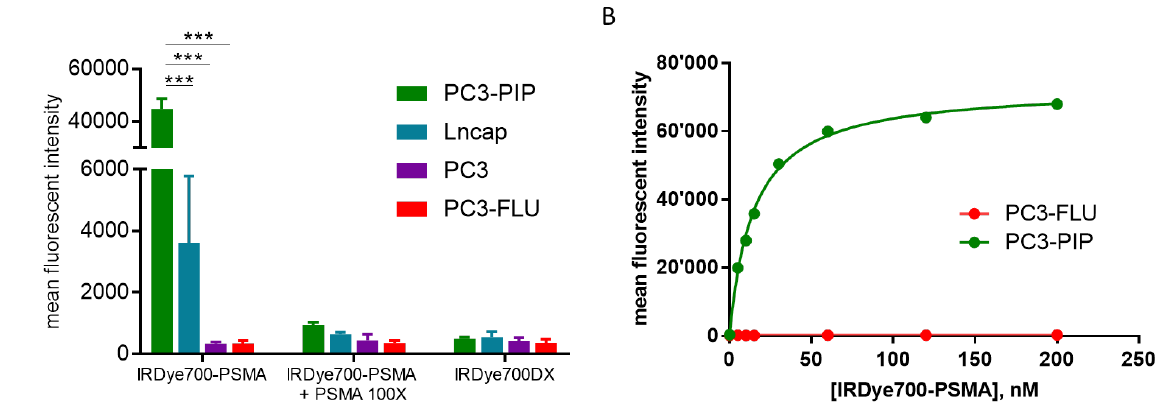
Figure 2. ( A ) Fluorescence emission of PC3-PIP (green), LNCaP (blue), PC3 (violet), PC3-FLU (red) cells following incubation with IRDye700DX-PSMA (500 nM), IRDye700DX (500 nM) and IRDye700DX-PSMA together with non-fluorescent peptide (50 µ M). 2-way anova Bonferroni post hoc, *** p < 0.0001 n = 3; ( B ) Dose-dependent binding of IRDye700DX-PSMA to PC3-PIP (PSMA+ cell) and PC-3- FLU (PSMA-) n = 1.